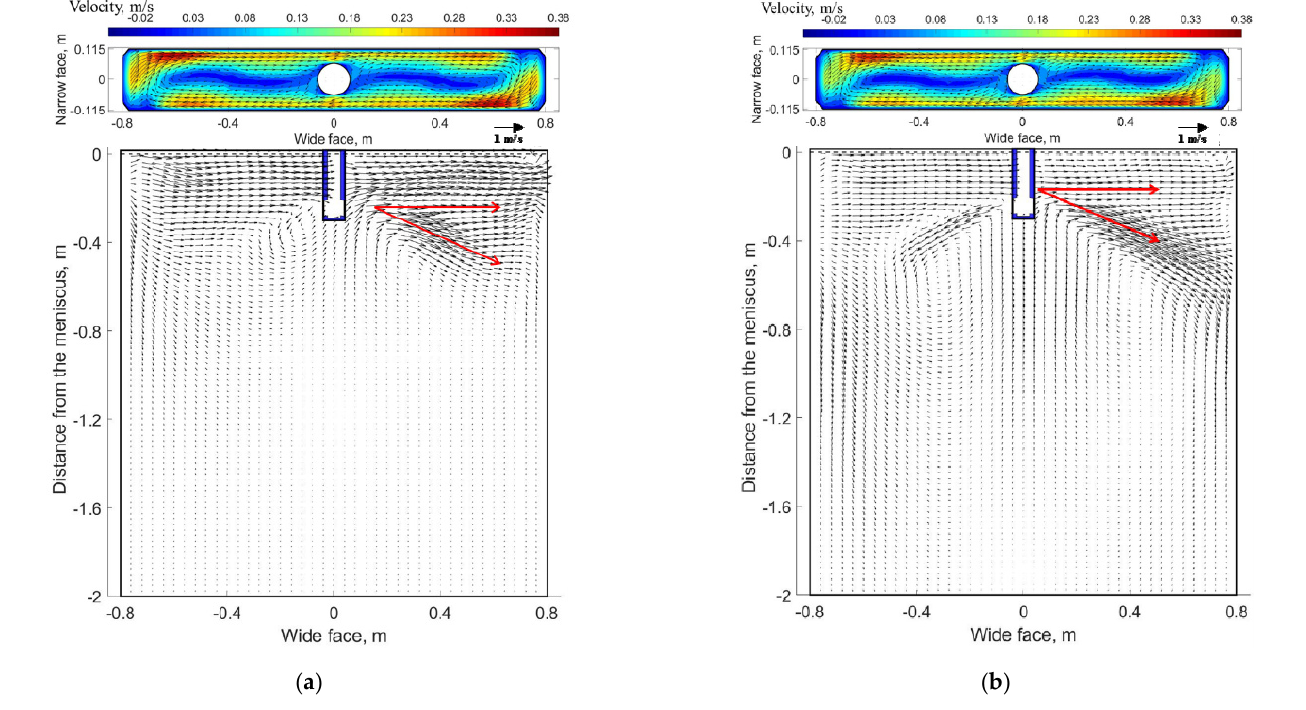
Figure 10. Velocity distribution at transverse plane (plane 1) and a quarter longitudinal plane (plane 2) at (600 A, 4 Hz): ( a ) 0.8 m/min, ( b ) 1.4 m/min.